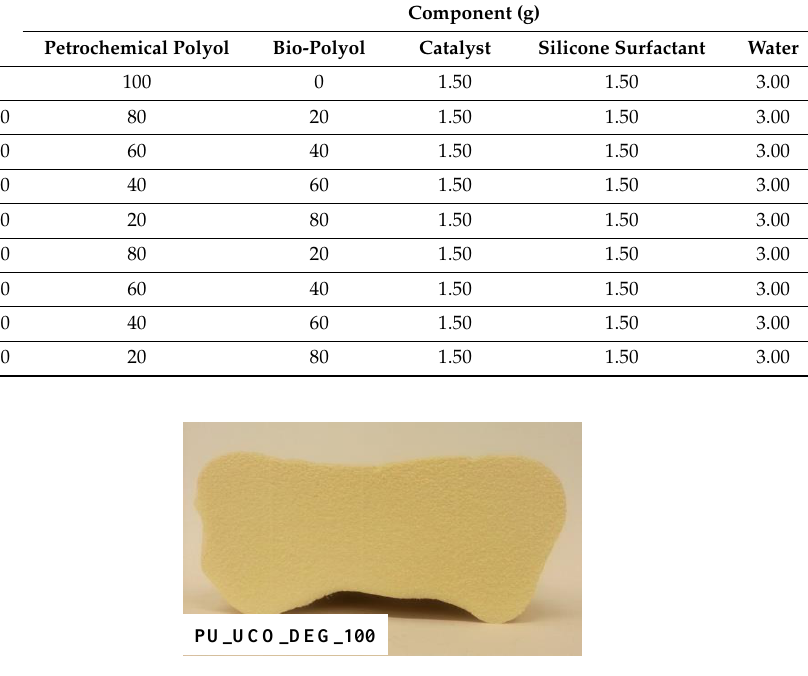
Figure 1. Foam PU_UCO_DEG_100 characterized by shrinkage. Table 2. Formulations of foam materials obtained with different amounts of the bio-polyols.